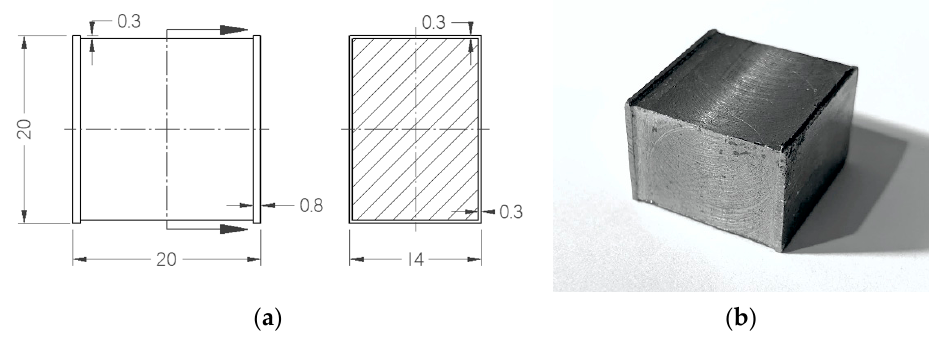
Figure 5. Schematic diagram of the specimens ( a ) and a specimen image ( b ).